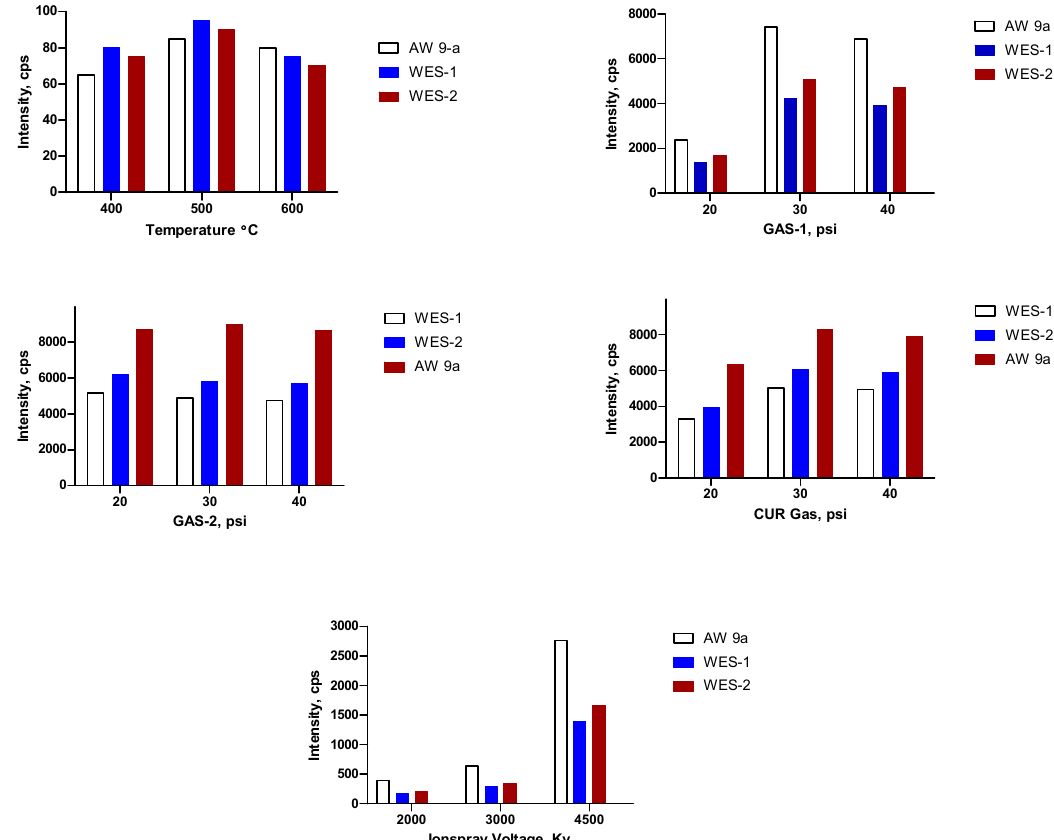
Figure 3. Optimization of the tandem mass spectrometry (MS/MS) parameters of the proposed method based on FIA MS/MS ALL compound optimization tool in Analyst Hotfixes TM software version 1.6.3.